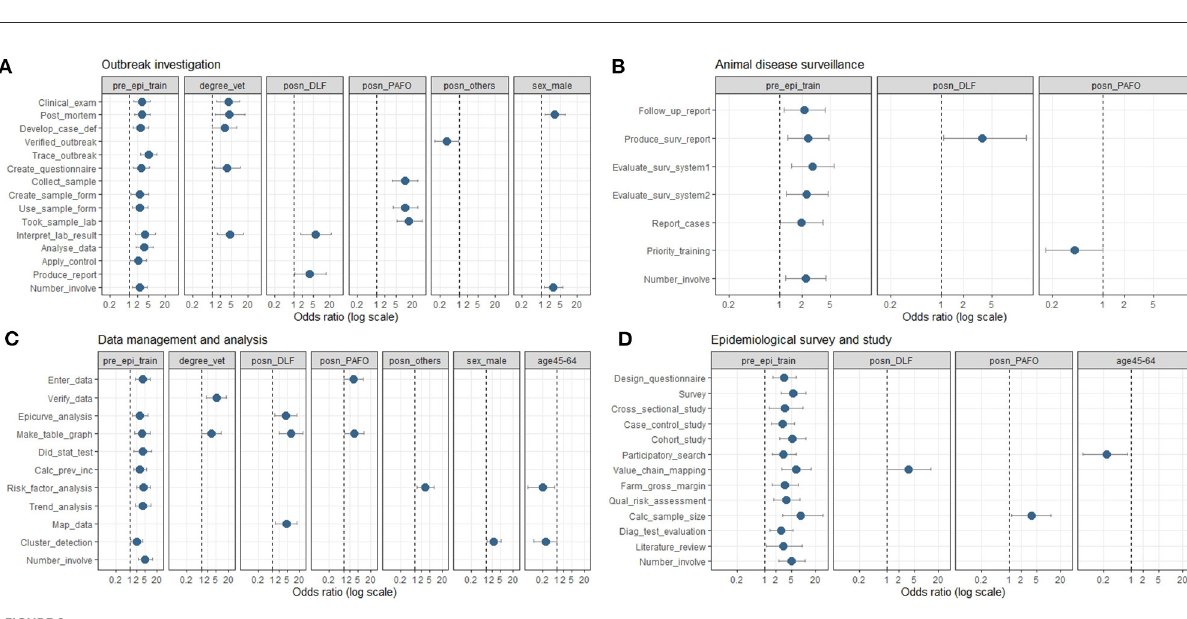
FIGURE2 Statistical significant associations ( p < 0.05) between skill outcomes and demographic variables for outbreak investigation (A) , animal disease surveillance (B) , data management and analysis (C) , and epidemiological surveys and studies (D) , based on multivariable ordinal logistic regression models adjusting for age, sex and prior epidemiology training experience from an online veterinary epidemiology capacity cross-sectional study in Lao PDR between February and March 2021. The point estimate of odds ratio (OR) is depicted as a circle, with the error bar indicating the 95% confidence interval. Key labels on the y-axis: def, definition; surv, surveillance; stat, statistical; calc, calculation; prev, prevalence; inc, incidence; Qual, Qualitative; Diag,